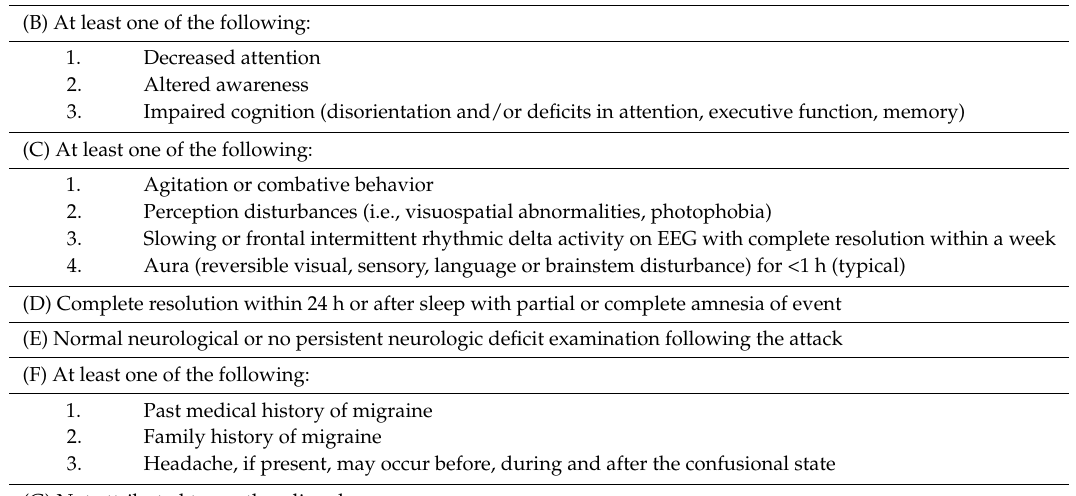
Table 2. Proposed Classification Criteria for A1.6 Episodic Syndromes that may be associated with migraine: Acute Confusional